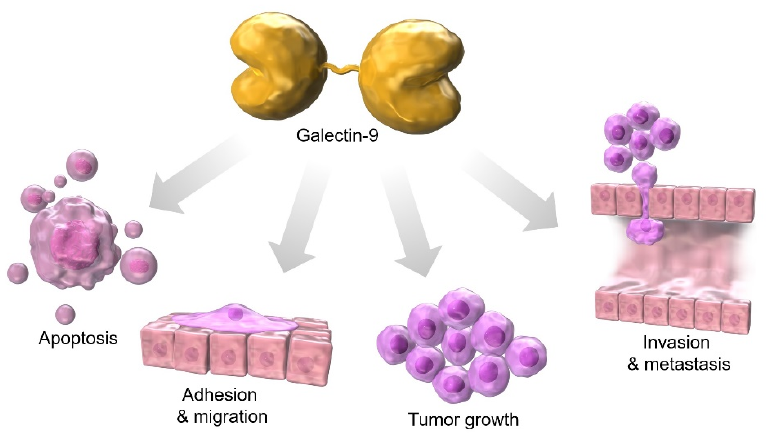
Figure 1. Galectin-9 is associated with apoptosis, adhesion, migration, tumor growth, invasion, and metastasis during cancer development.